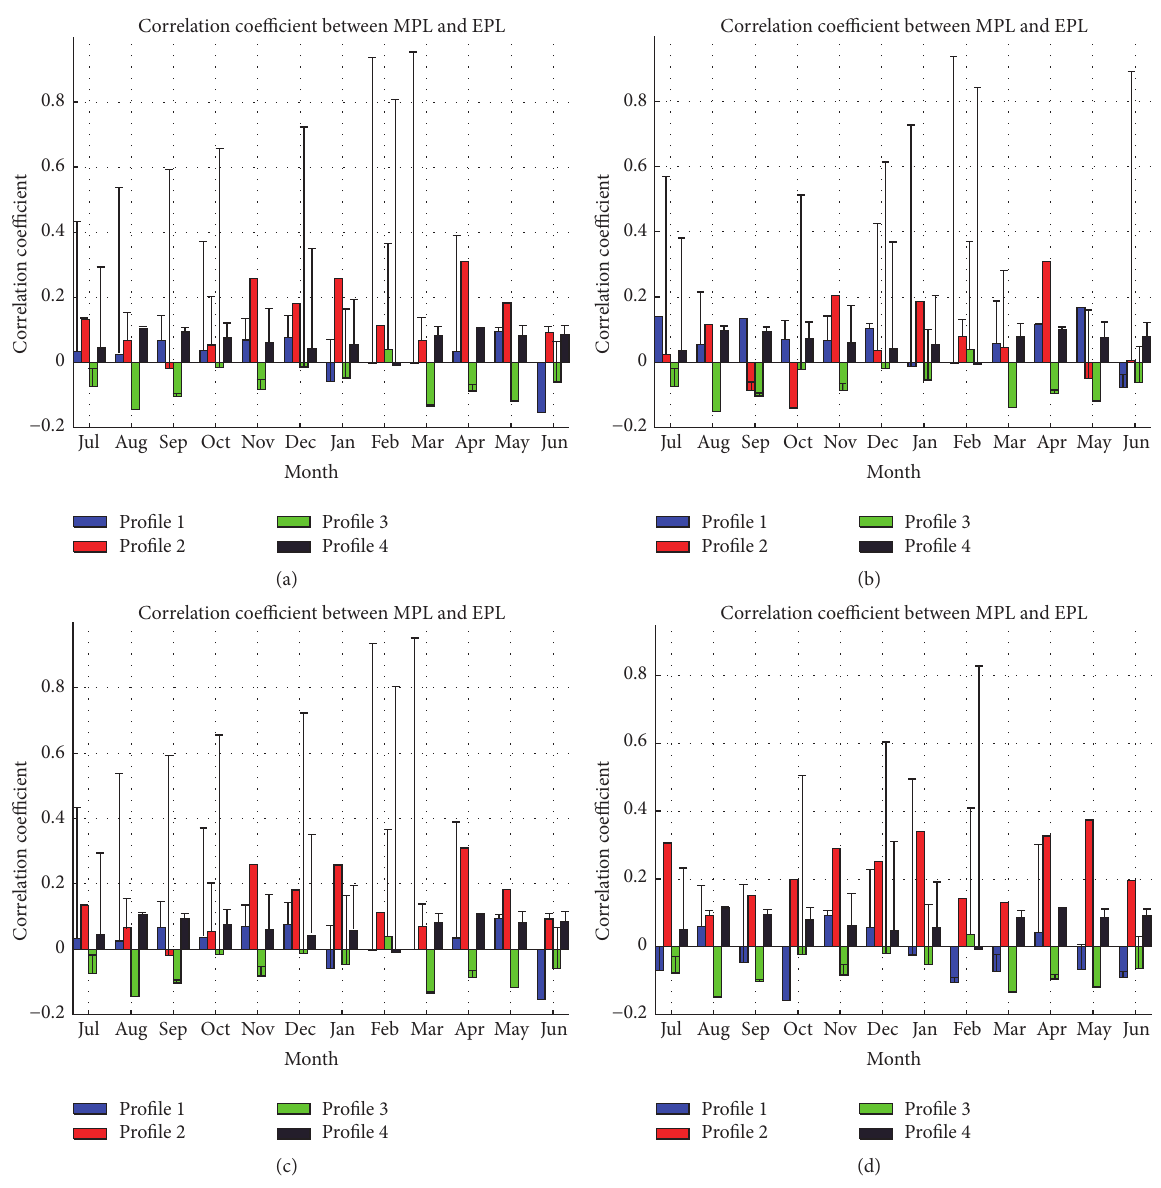
Figure 2: Monthly correlation coefficients for different 𝑀 profiles for “Link 2” in case of (a) 0 m EDH, (b) 10m EDH, (c) 20m EDH, and (d) 30m EDH. The bar and line represent the correlation coefficient and 𝑝 value, respectively. MPL and EPL are the modelled path loss and experimental path loss,